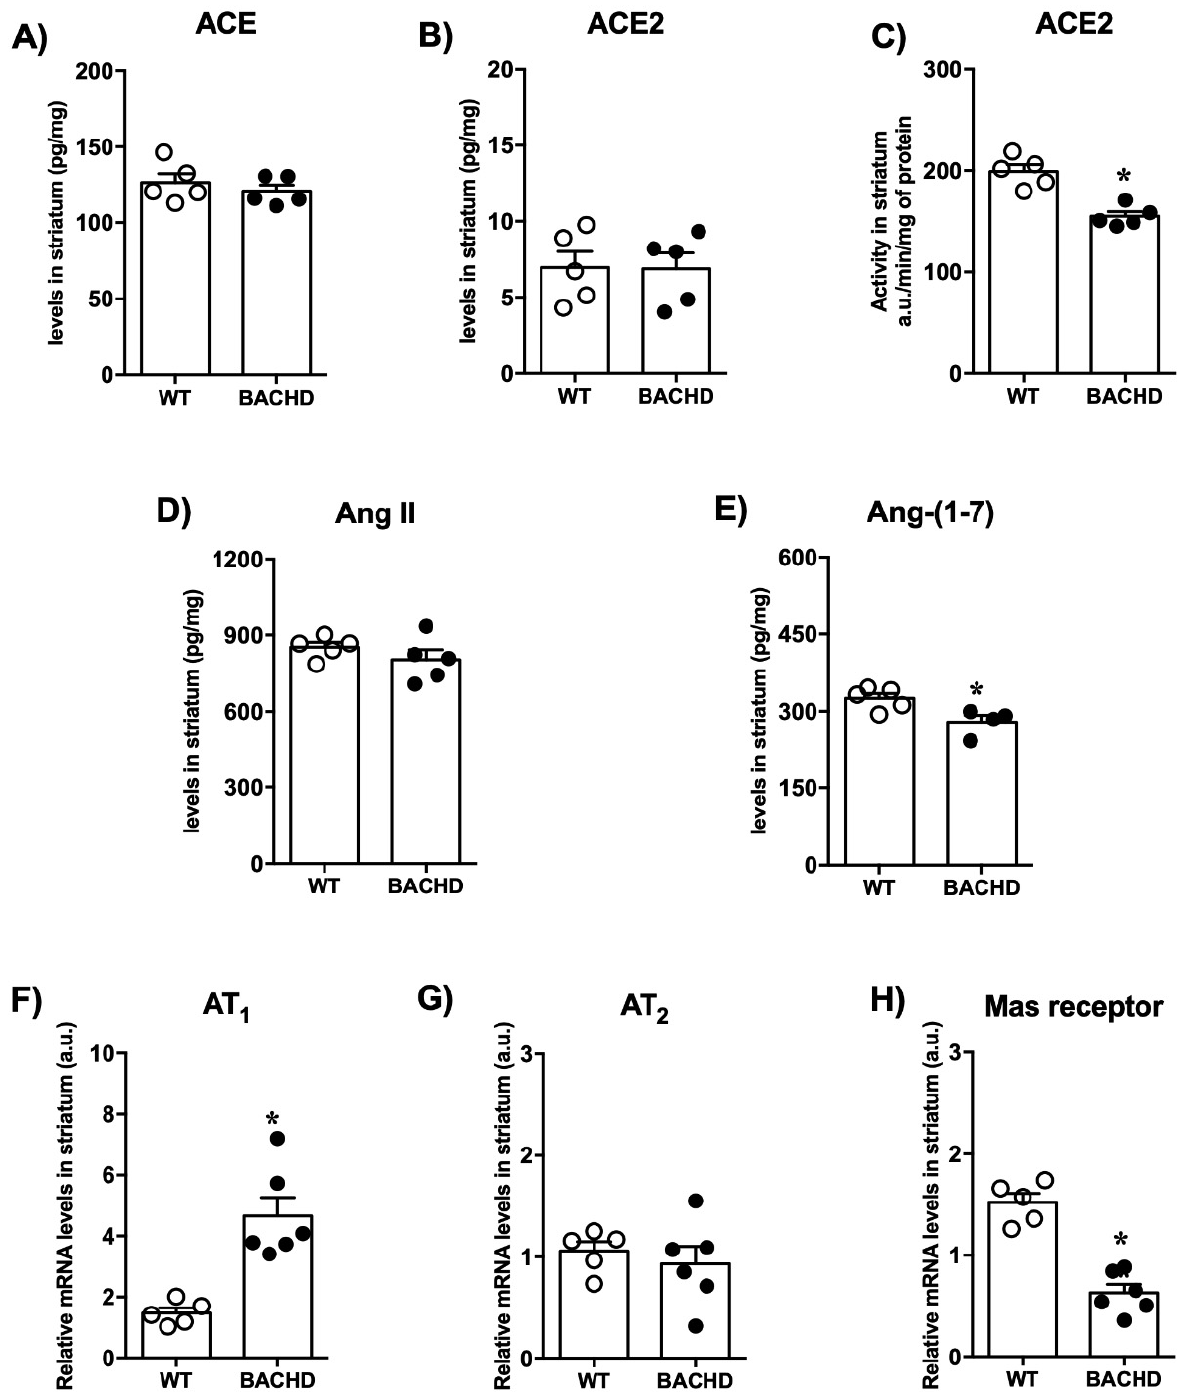
Figure 3. RAS components’ levels in the striatum of BACHD and WT mice. ( A ) ACE, ( B ) ACE2 levels, ( C ) ACE2 activity, ( D ) Ang II levels, ( E ) Ang-(1-7) levels, ( F ) AT 1 receptor expression, ( G ) AT 2 receptor expression, and ( H ) Mas receptor expression in the striatum of BACHD mice. Results are expressed as mean ± SEM. n = 5–6. * p < 0.05 compared with WT group. The data were analyzed by Student’s t -test.